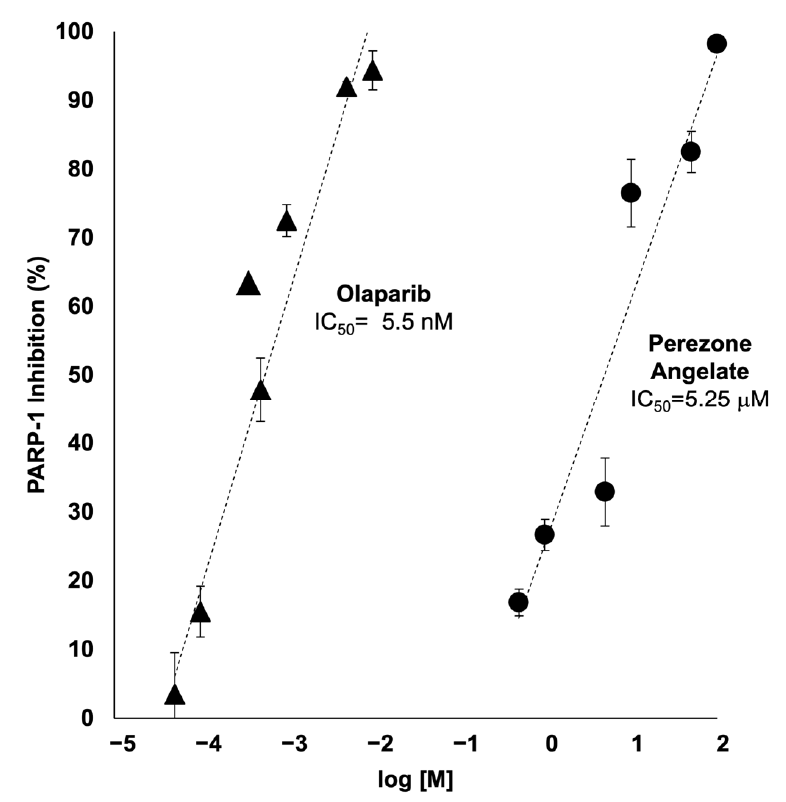
Figure 5. PARP-1 inhibition activity of perezone angelate (circles) and olaparib (triangles). According to the manufacturer’s instructions (PARP-1 colorimetric assay kit BPS Bioscience, USA, Catalog Number 80580). Values on the graph represent mean values, and vertical bars denote standard error ( n = 3). The half maximal inhibitory concentration (IC 50 ) was estimated for each compound through linear regression analysis.